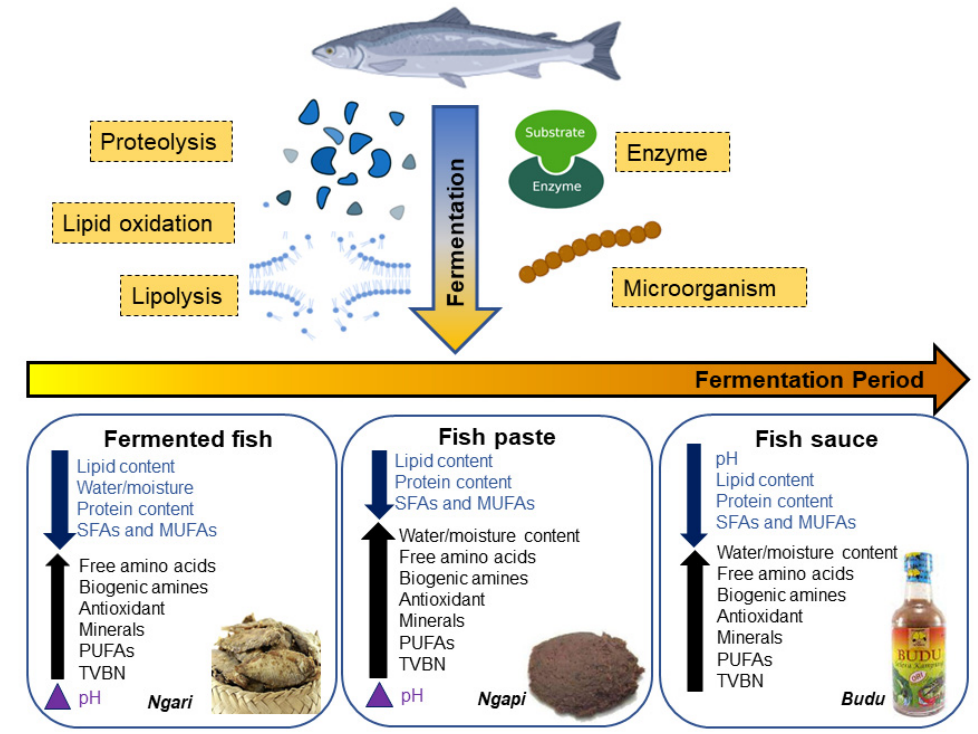
Figure 3. Biochemical reactions and changes during fish